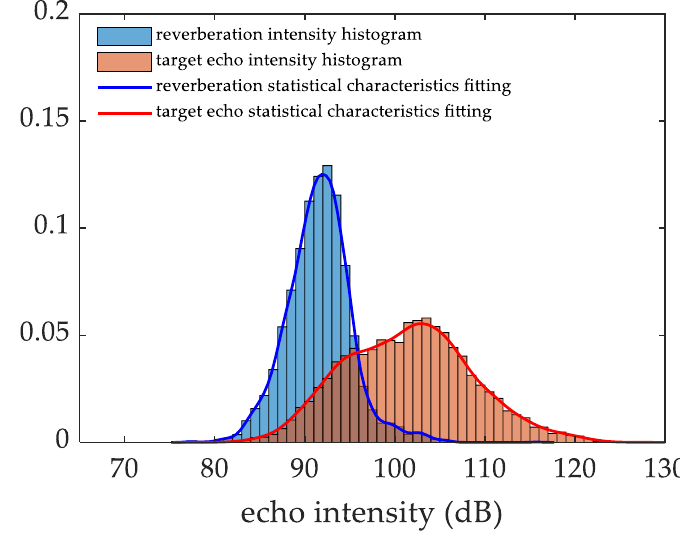
Figure 10. Statistical characteristics of reverberation and target echo data.